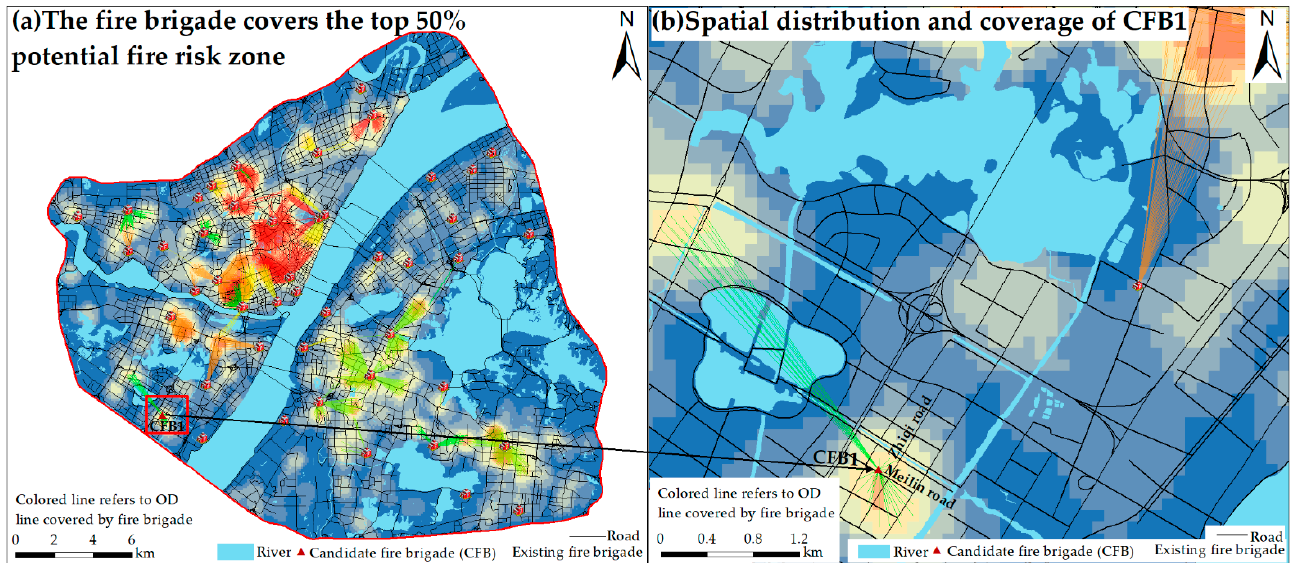
Figure 15. Spatial distribution of fire brigades that satisfy the needs of the top 50% high-fire-risk zones.